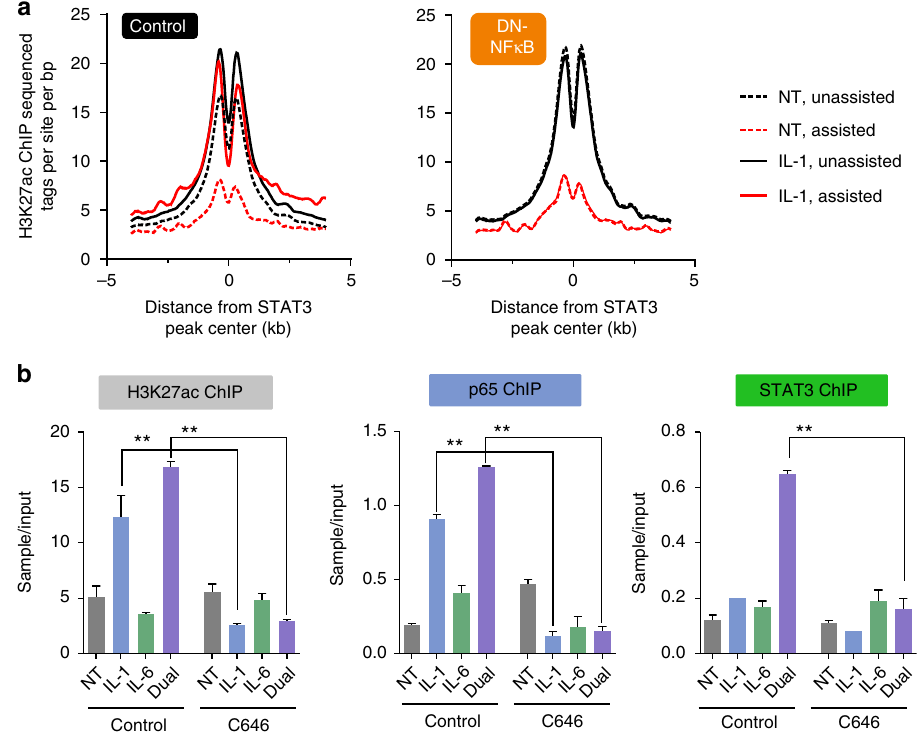
Fig. 7 IL-1 β enhancer priming is mediated by NF- κ B and is brought about by p300/CBP-dependent H3K27ac. a The IL-1 β -dependent increase in H3K27 acetylation at assisted sites is negated in the presence of a dominant negative peptide inhibiting NF- κ B activity (left panel replicated from Fig. 4e). b ChIP- qPCR of the Saa1/2 enhancer shows that assisted loading as well as H3K27ac is negated in the presence of a p300/CBP inhibitor (C646). Representative experiment shown of two independent repeats. Error bars represent s.d. of three technical replicates. Double asterisks denote p -value ≤ 0.01 as determined by an unpaired, two-tailed t